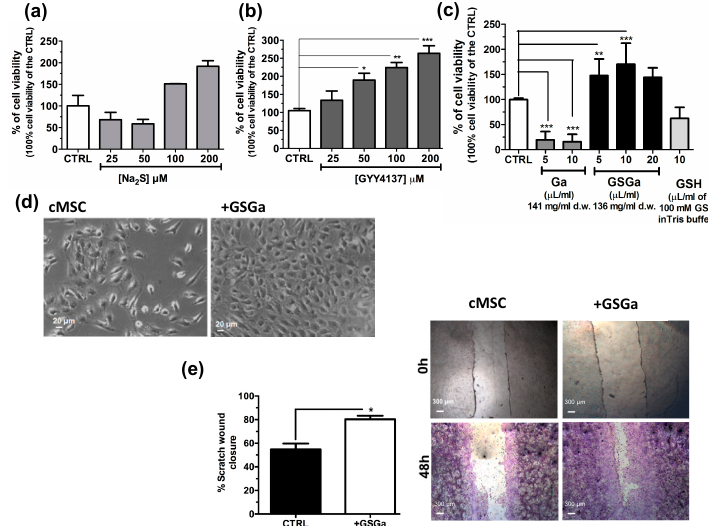
Figure 1. Effects of H 2 S slow-releasing agents on cell proliferation and migration of cMSC. Cell proliferation of cMSC (5 × 10 3 cells/cm 2 ) after 3 days of treatment at different concentrations of ( a ) Na 2 S (25, 50, 100 and 200 μ M) and ( b ) GYY4137 (25, 50, 100 and 200 μ M); ( c) cell proliferation of cMSC treated for 3 days with 5 and 10 μ L of Ga (141 mg/mL d.w) and 5, 10 and 20 μ L of GSGa (136 mg/mL d.w). ( d ) Bright field micrographs of cMSC cultured for 3 days in the presence and in the absence of 136 μ g/mL of GSGa. ( e ) Scratch wound healing assay on cMSC cultured in the absence (cMSC) or in the presence of 680 μ g/mL of GSGa (+GSGa). Micrographs in the upper and lower panels were taken immediately after the scratching (0 h) and after 48 h (48 h) respectively; cells shown in the lower panels were stained with crystal violet dye. Quantification of wound closure was calculated by three independent experiments. Error bar indicates S.D.; n = 3 or 5. Statistical significance is shown as * p value ≤ 0.05, ** p value ≤ 0.01, *** p value ≤ 0.005.